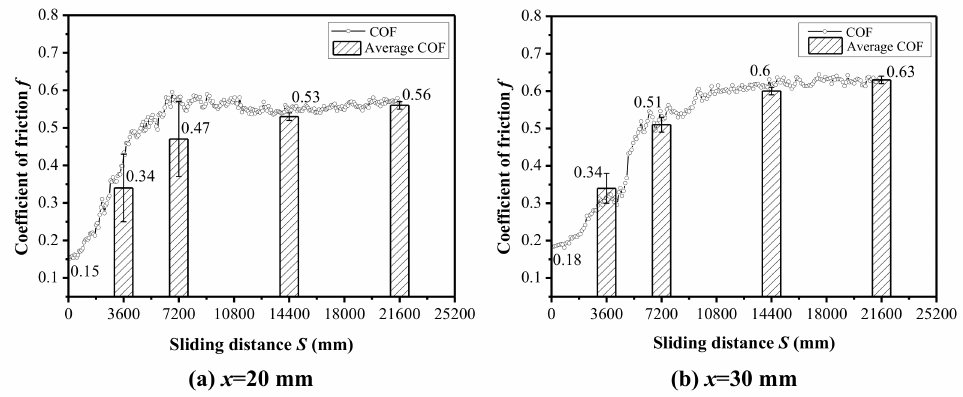
Figure 4. The evolution of the coefficient of friction under different strokes. ( a ) Stroke: 20 mm, load: 100 N; ( b ) stroke: 30 mm, load: 100 N.